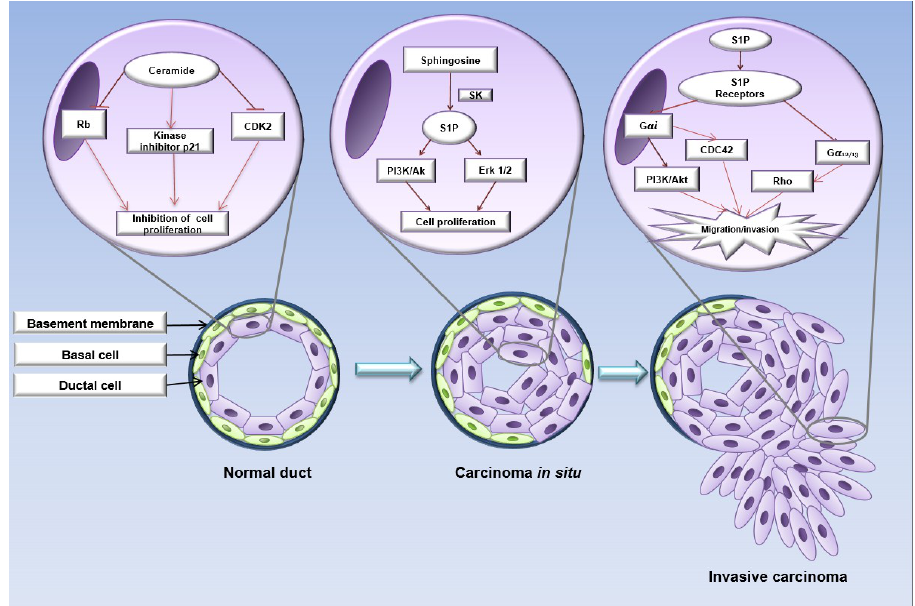
Figure 3. Schematic view of sphingolipid role in breast cancer progression. Structurally, the mammary ducts are composed of basal membrane, a layer of myoepithelial cells and another of luminal ductal cells. In the normal mammary epithelium, ceramides negatively regulate the Rb and CDK2 proteins, inhibiting cell proliferation. In carcinoma in situ, luminal tumor cells present an abnormal metabolism of ceramides, where sphingosine-1-phosphate (S1P) through S1PR promotes activation of the PI3K/Akt and MAPK pathways, inducing cell proliferation. The loss and/or degradation of the basement membrane allow the tumoral cells to migrate and invade the surrounding tissue. In this stage, S1PR promotes GTPases activation such as Rho and CDC42, inducing tumor invasion and consequently, metastasis. Image adapted from references: